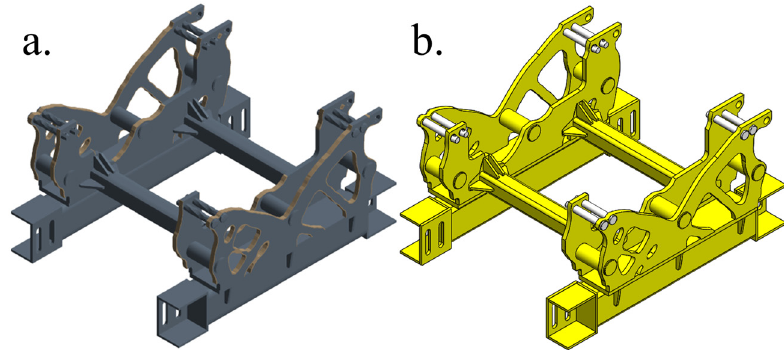
Figure 15: Topology optimized results from PS3 ( * = V 50%, 1:1:2:2 weights with more emphasis on torque testing ) : ( a ) density iso - line using ≥ ρ 0.6 in workbench and ( b ) CAD model created in SolidWorks.